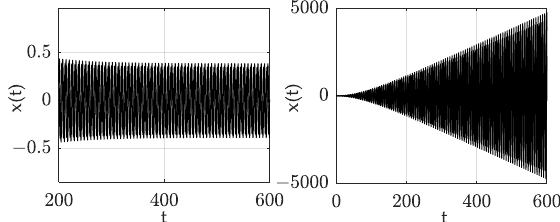
Figure 7. Response of point E, with F=0 ( left ) and F=1 ( right ).